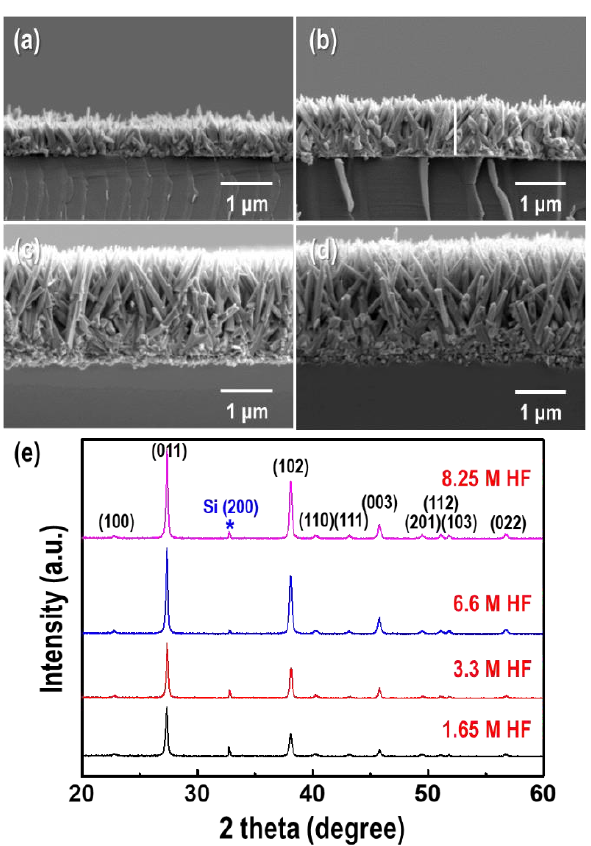
Figure 3. Hydrofluoric acid (HF) concentration dependence of the morphology and dimensions of the Te nanorod arrays. Cross-section FE-SEM images of the Te nanorod arrays formed at HF concentrations of ( a ) 1.65 M, ( b ) 3.3 M, ( c ) 6.6 M. and ( d ) 8.25 M, respectively. ( e ) Corresponding XRD patterns of the Te nanorod arrays. The concentration of TeO 2 and GDR time were fixed at 1.5 mM and 9 h, respectively.